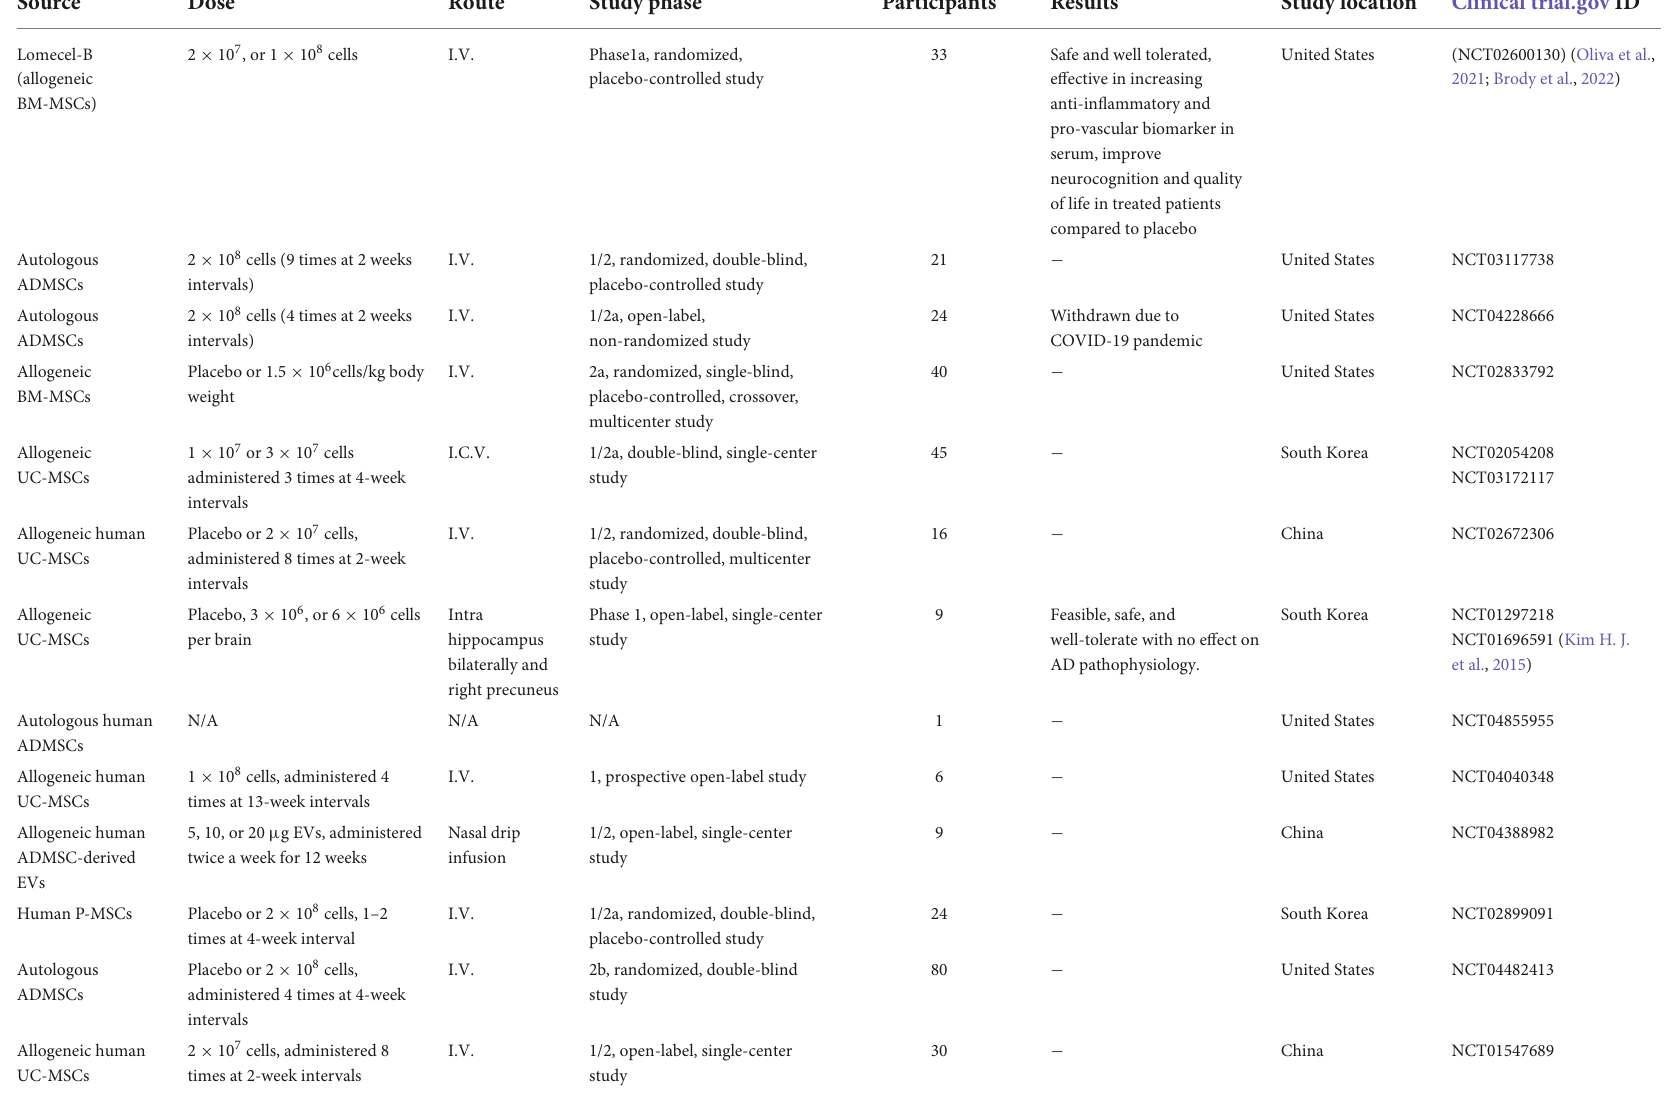
TABLE 2 Use of MSCs in Alzheimer’s disease in different clinical